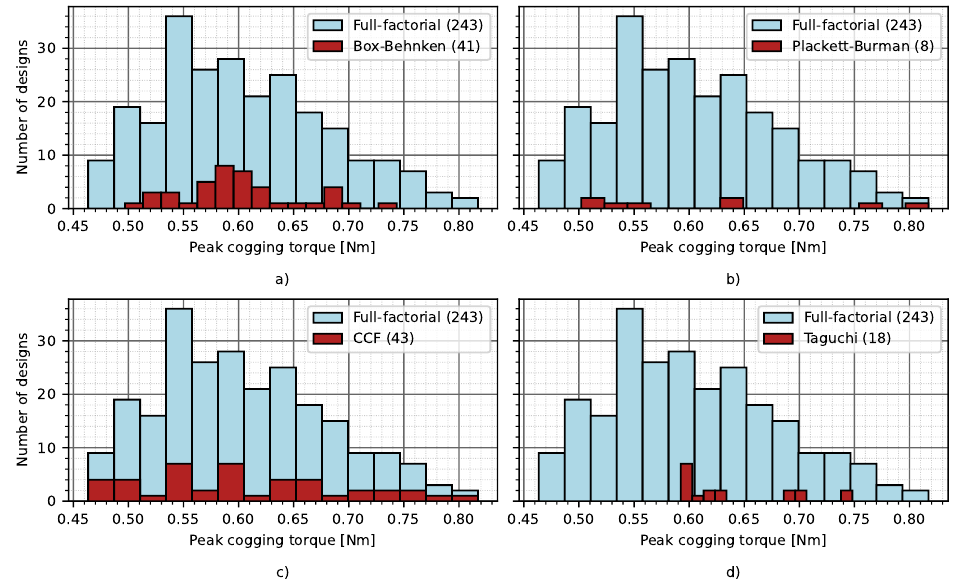
Figure 14. The distribution of the peak value of the cogging torque with the different Doe strategies: Box-Behnken ( a ), Plackett-Burman ( b ), CCF ( c ), and Taguchi ( d ), which were compared with the Full-factorial design.